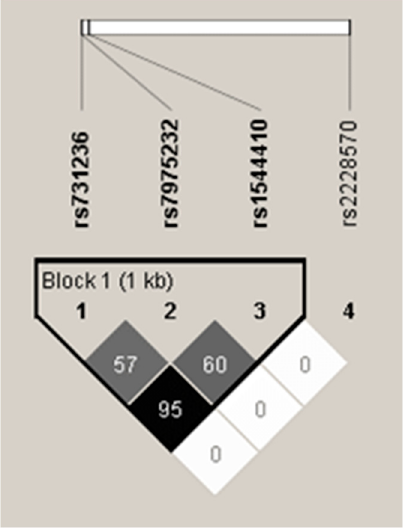
Figure 1. Values of linkage disequilibrium (LD) between the studied polymorphisms. Analysis was performed using Haploview 4.2 software.